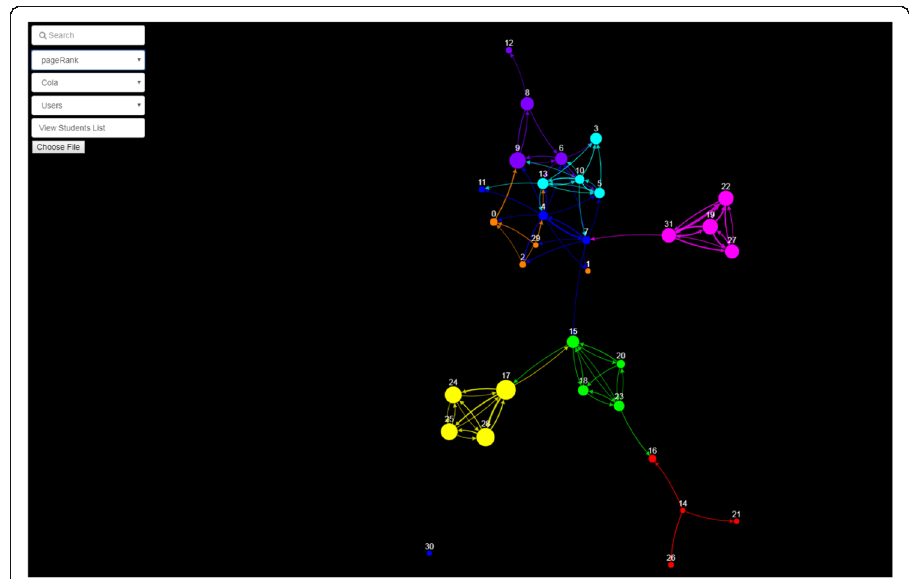
Fig. 10 Students ’ collaboration on Blogger. The visualization is provided by StudentViz using WebCola layout. Nodes represent students and their diameters are proportional to PageRank metric. Through this image, the instructor can visualize the collaboration status for a specific social media tool (in this case, the blog). This figure supports VN1 and VN2, as well as P1, P2 and P3